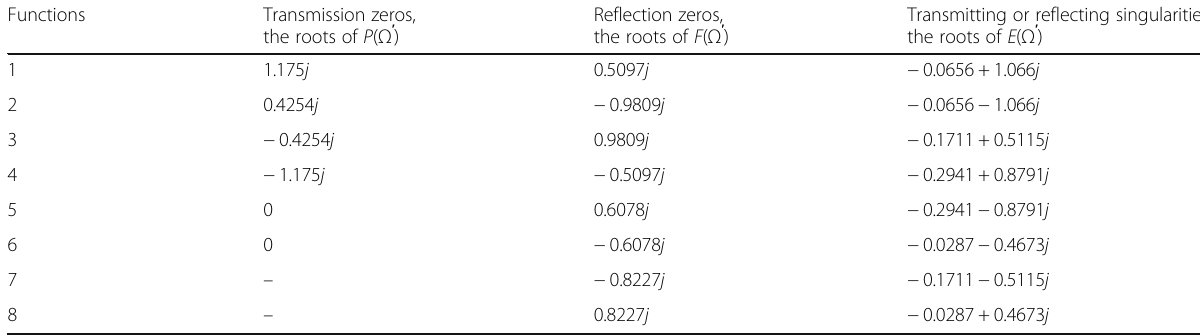
Reflection zeros, the roots of F ( Ω ′ )